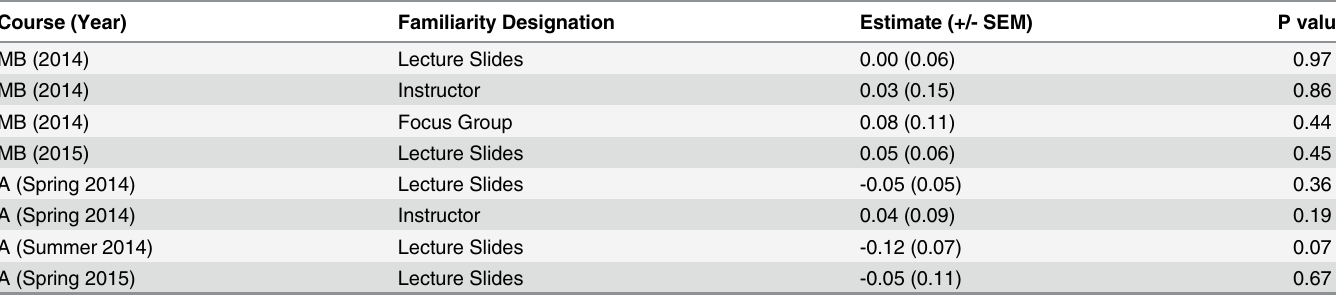
Table 3. Summary comparison of performance on F and NF questions only.